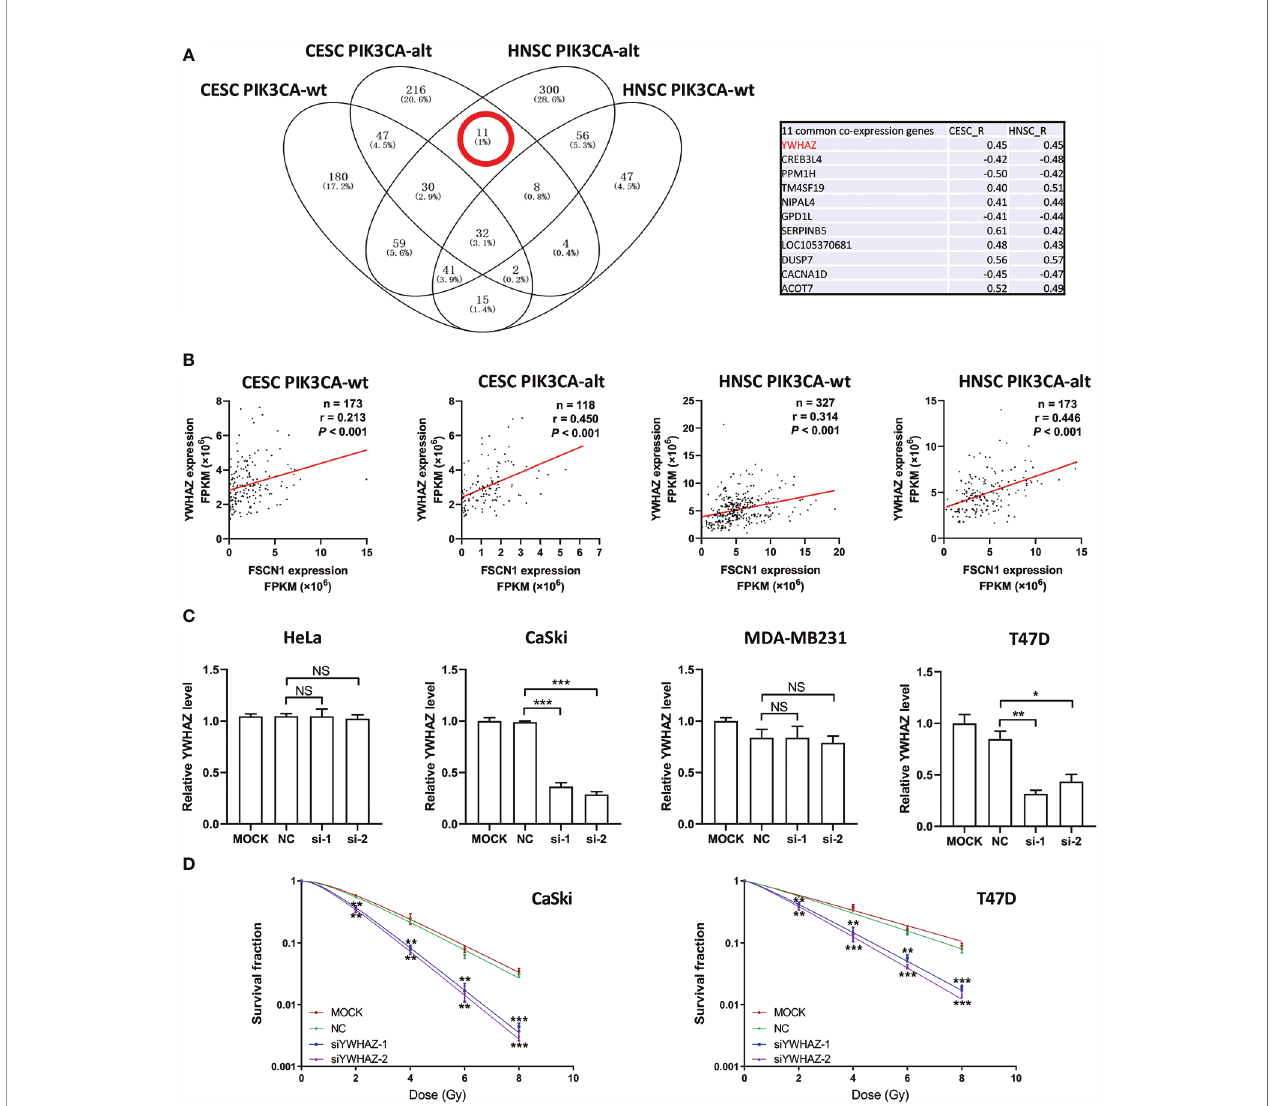
FIGURE 4 | FSCN1 regulates the expression of YWHAZ in cancer cells with PIK3CA alterations. (A) Venn diagram shows FSCN1-correlated genes in CESC and HNSC patients with wild-type or altered PIK3CA. Eleven genes were coexpressed with FSCN1 in the PIK3CA-altered group of cervical cancer and head and neck cancer patients. Pearson correlation coef fi cient values are shown in the table. (B) Pearson correlation analysis for the expression levels of FSCN1 and YWHAZ. Graphs show a stronger positive correlation between FSCN1 and YWHAZ in patients with altered PIK3CA than in those with wild-type PIK3CA according to TCGA data. (C) Relative expression of YWHAZ analyzed by qRT-PCR in HeLa, CaSki, MDA-MB-231, and T47D cells transduced with FSCN1 siRNAs. (D) Knockdown of YWHAZ sensitizes cancer cells to IR treatment. Colony formation assays of CaSki and T47D cells transfected with YWHAZ siRNA. Surviving fractions were determined based on plating ef fi ciencies. PIK3CA-wt, wild type PIK3CA; PIK3CA-alt, mutated or ampli fi cated PIK3CA. For (C, D) , data are presented as the means±SEM of at least three independent experiments. * P < 0.05; ** P < 0.01; *** P < 0.001. NS, not signi fi